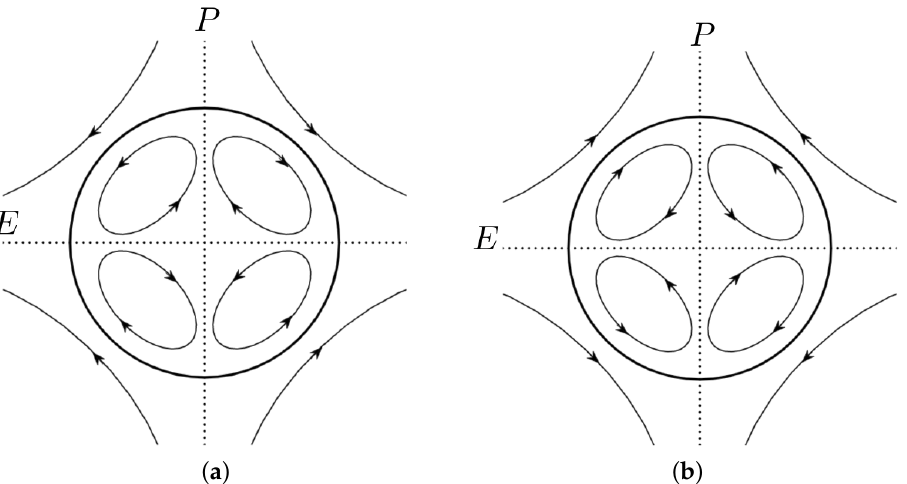
Figure 5. Schematics representation of two types of induced flows based on the Taylor’s theory: ( a ) R < S and ( b ) R > S . Reproduced from Shadloo et al. [43].